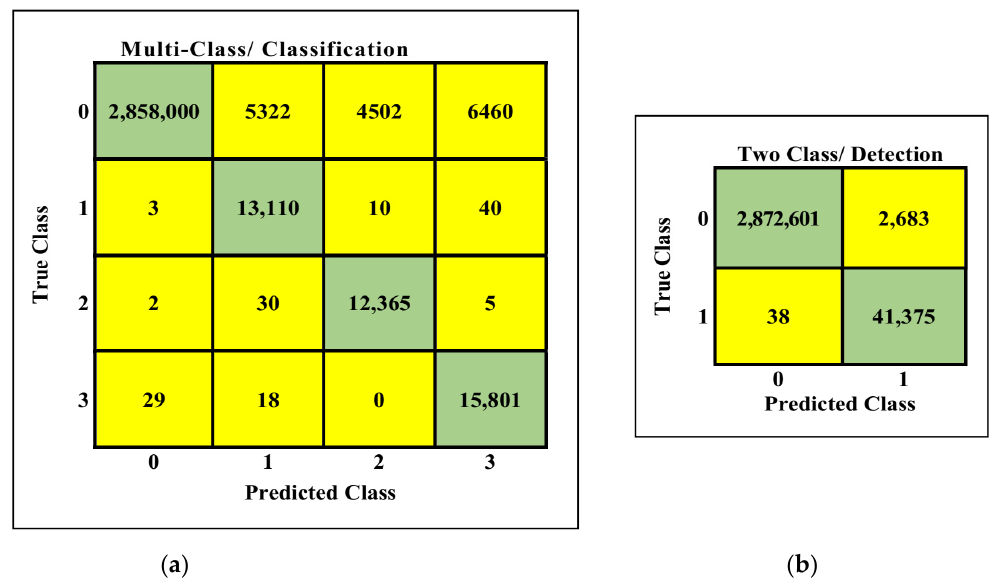
Figure 11. Confusion Matrix Analysis for predictive models using ODT: ( a ) Classification System and ( b ) Detection Sys- tem.